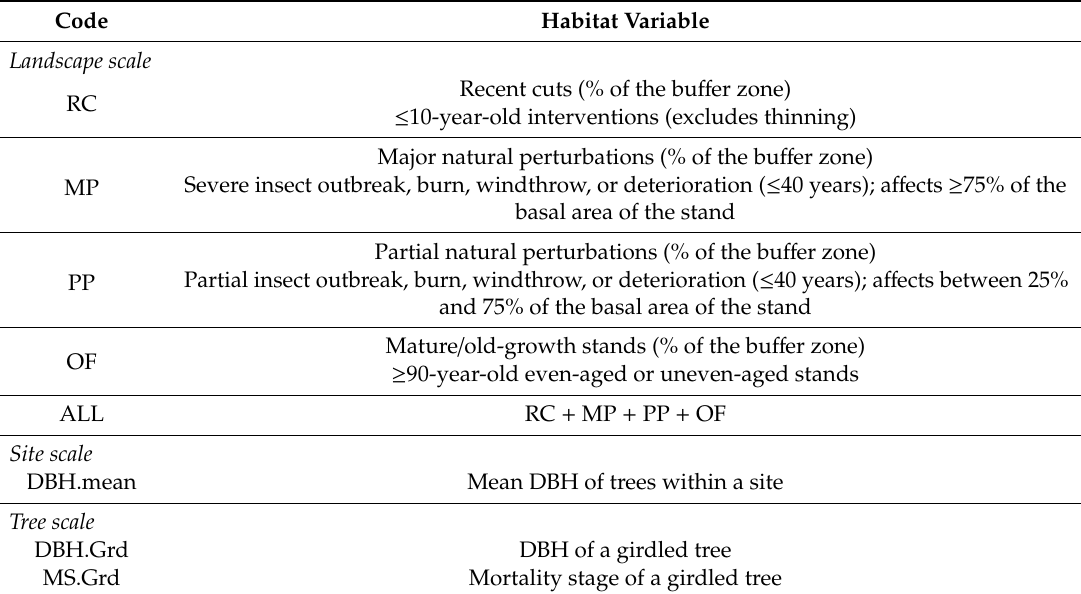
Table 1. List and description of habitat